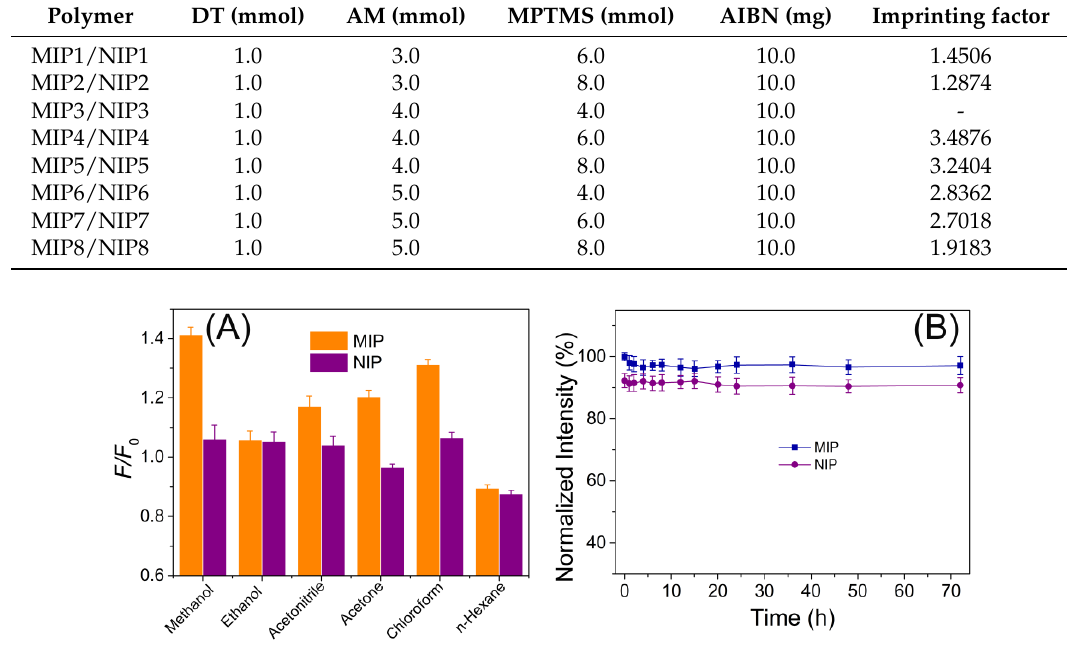
Table 1. The optimization of template/monomer/cross-linker ratios for the polymerization.